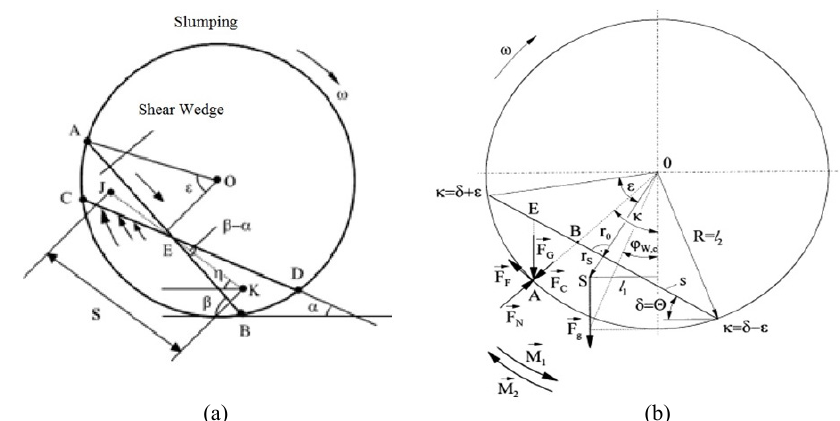
Fig. 2: (a) Material bed motion in slumping mode, and (b) material bed motion in rolling